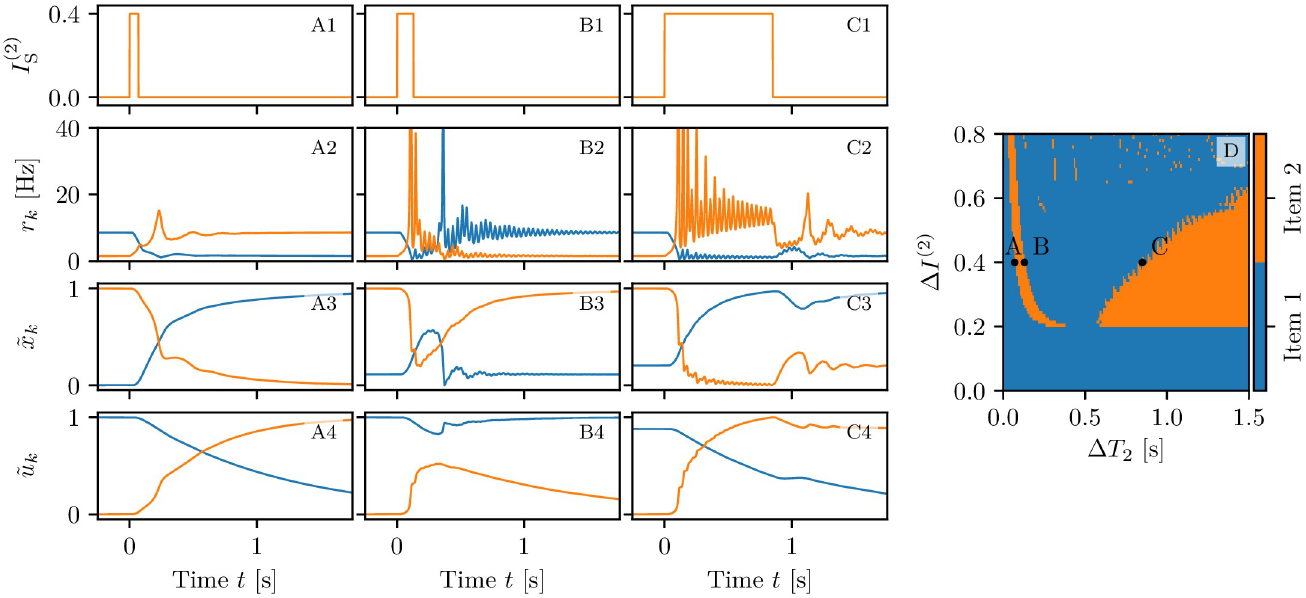
Fig 7. Memory item switching with persistent activity. The three columns (A-C) refer to three values of Δ T 2 for which we have a memory switching from one item to the other for a background current I B = 2 supporting persistent state activity. (A) Δ T 2 = 70 ms; (B) Δ T 2 = 130 ms and (C) Δ T 2 = 850 ms. Profiles of the stimulation ð t Þ for the second excitatory population ( A1-C1 ). Population firing rates r current I ð 2 Þ S utilization factors ~ u ð t Þ ( A4-C4 ) of the excitatory populations calculated from the simulations of the neural mass model. Final memory states as a function of the l amplitude Δ I (2) and width Δ T 2 of the stimulus to population two ( D ). In ( D ) the three letters A, B, C refer to the states examined in the corresponding columns. Other parameters as in Fig 3, apart for I B =